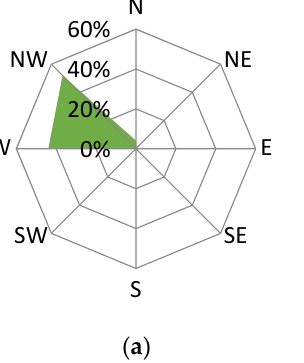
Figure 6. Dominant wind direction ( a ) and dominant air masses ( b ) on 20 July 2015 in Gdynia. Another situation was recorded on 16 September 2015, when the NO 3 − /SO 42 − ratio reached its maximum value during the entire measurement period, equal to 2.7. The likely cause of the increase in nitrate concentration was the film festival taking place in Gdynia and the related increased traffic volume. On that day, the wind direction from the east (in the morning) and from the south-east (afternoon hours) was recorded (Figure 7). The wind speed was low (on average 1.4 m · s − 1 ), which led to the accumulation of pollutants close to the emission source and their poor dispersion [5,80]. The obtained value of the PIR/B(a)P ratio, amounting to an average of 2.2, indicated the role of petrol-powered cars in the formation of high concentrations of ∑ PAH 5 (20.75 ng · dm − 3 ).